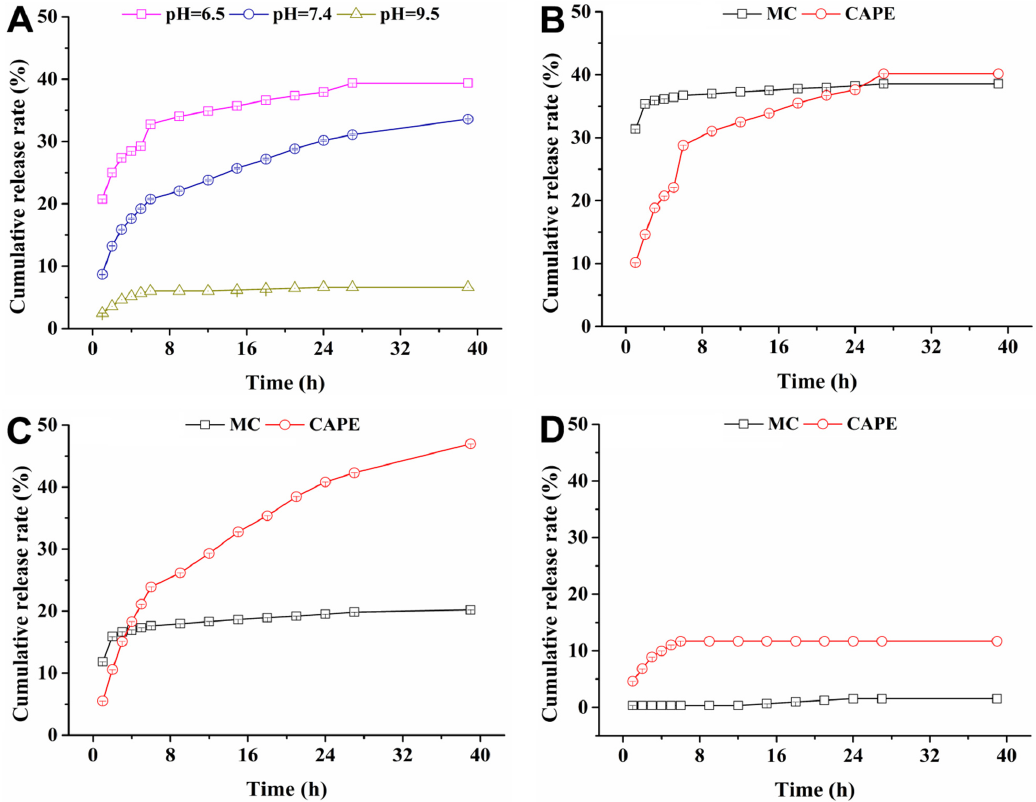
Figure 5. Sustained-release performance of PLGA-TNPs loaded with MC and CAPE ( A ) and release curves of MC and CAPE at a pH of 6.5 ( B ), 7.4 ( C ), and 9.5 ( D ). PLGA-NPs were prepared at a 1:1 ratio of EDC to NHS, with 30 min of activation time, a pH of 7, and 40 min of antibody binding time.